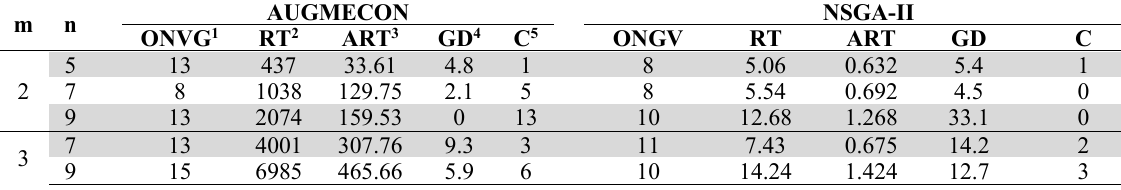
Comparison of AUGMECON and NSGA-II results